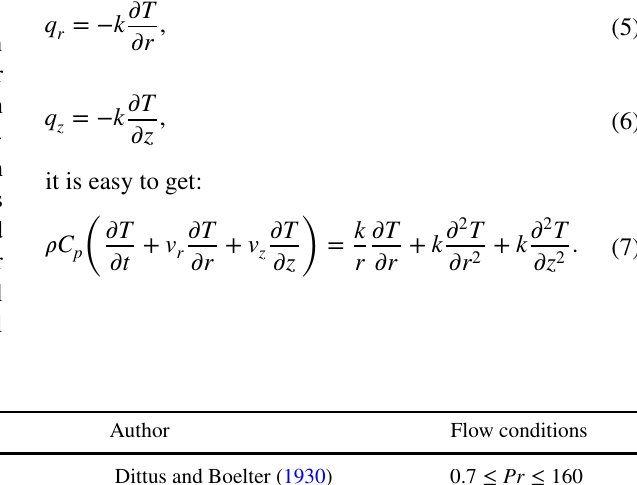
convection correlations for circular tubes (Bergman et al.